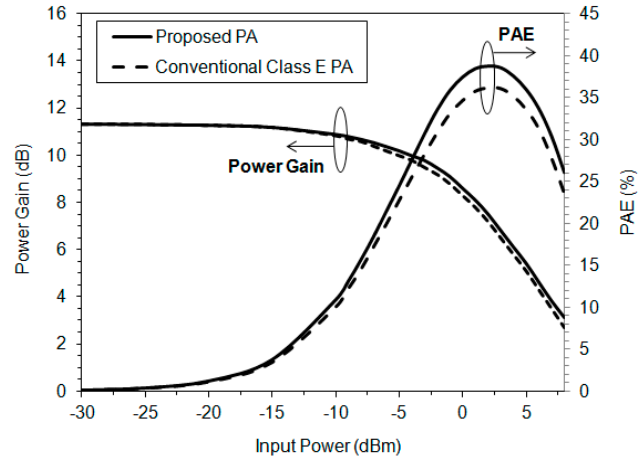
Figure 8. Simulated input–output response of the proposed PA (solid line) and the conventional class-E PA (dotted line)